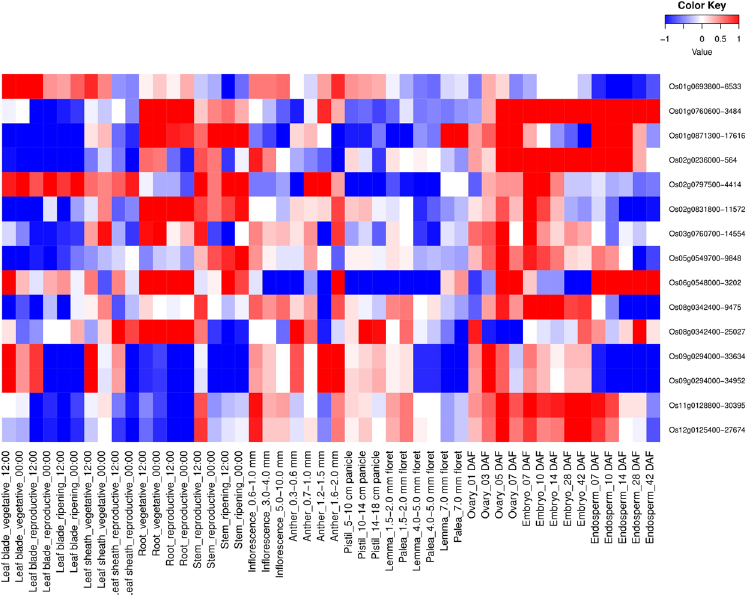
Figure 5. Heatmap representing the spatio – temporal expression profiling of tissues and organs at diverse developmental stages of AbSR –ThrMPG which are differentially expressed under natural field conditions. Red color - up regulation; Blue color - down regulation; White color - unchanged. The colored scale bar at right side top denotes relative expression value, where -1 and 1 represent down and up regulation of AbSR –